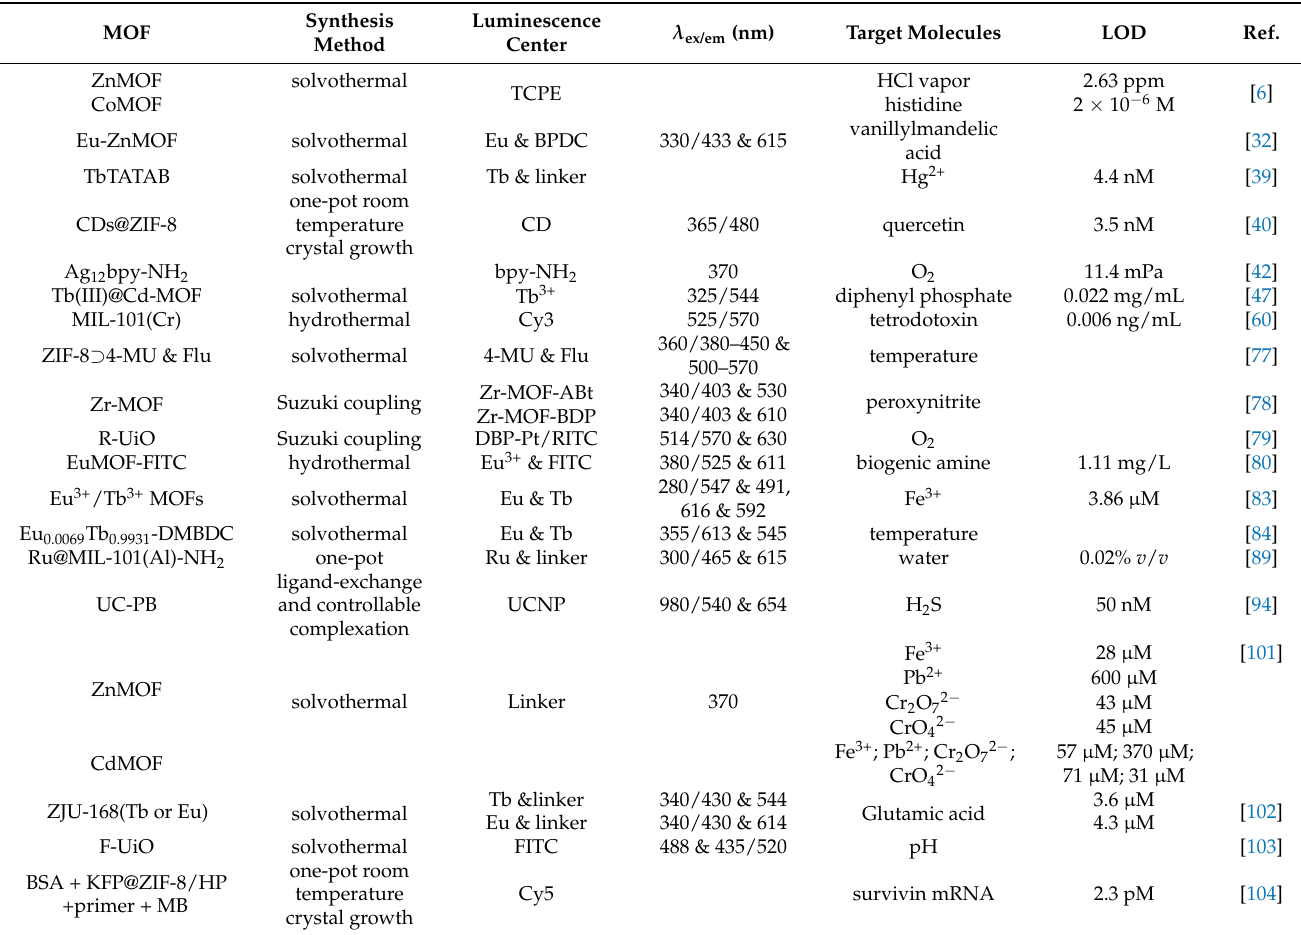
Table 1. Summary of MOF based fluorescence